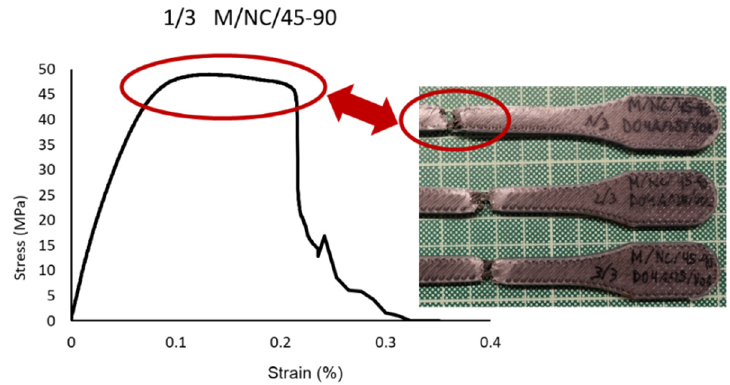
Figure 23. Break detail of 1/3 M/NC/45-90 specimen and stress-strain graph.